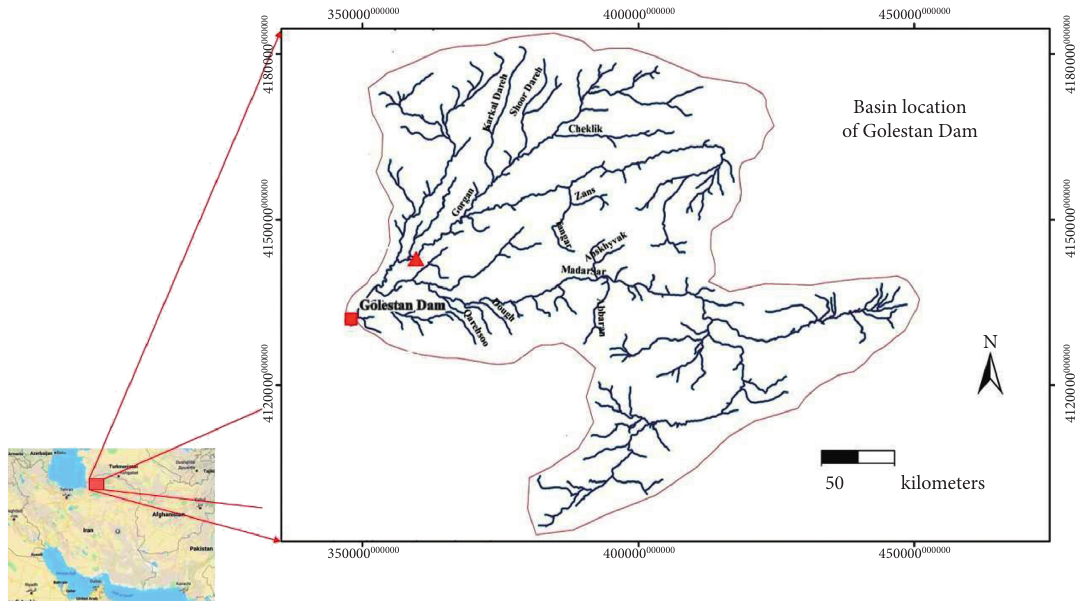
Figure 3: The geographical location of the study region.